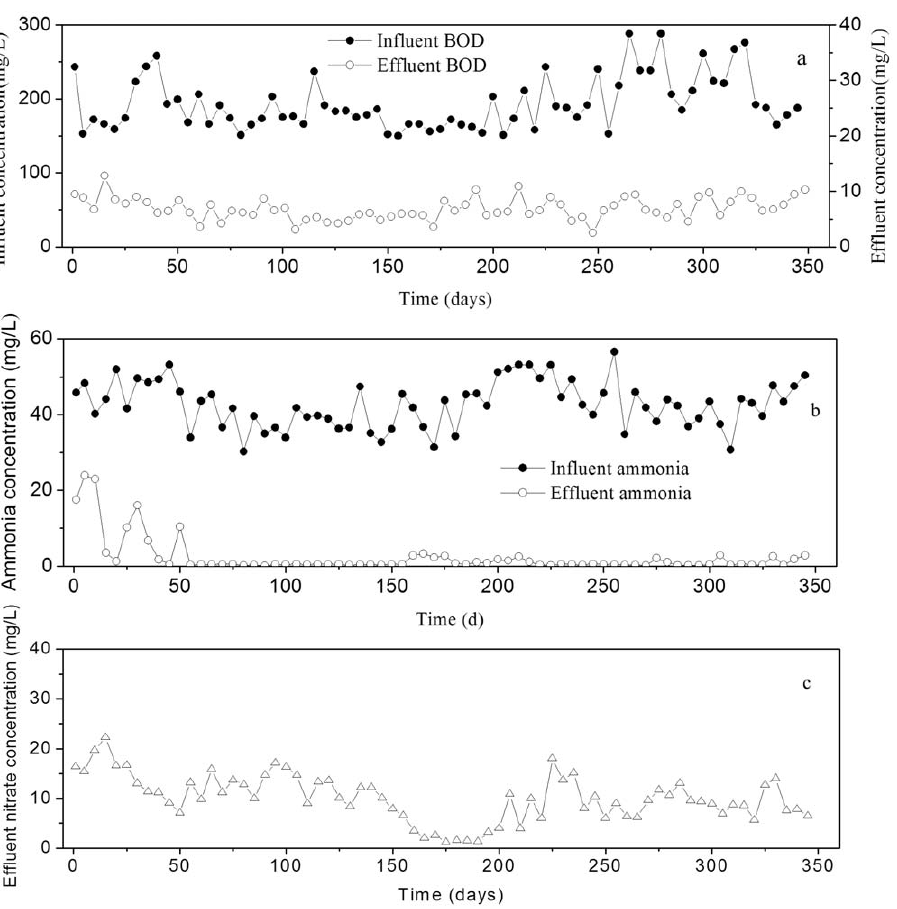
Figure 1. Functional performance in the pilot-scale wastewater treatment system over 345 days. (a) Influent and effluent BOD concentrations. (b) Influent and effluent ammonia concentrations. (c) Effluent nitrate concentrations.